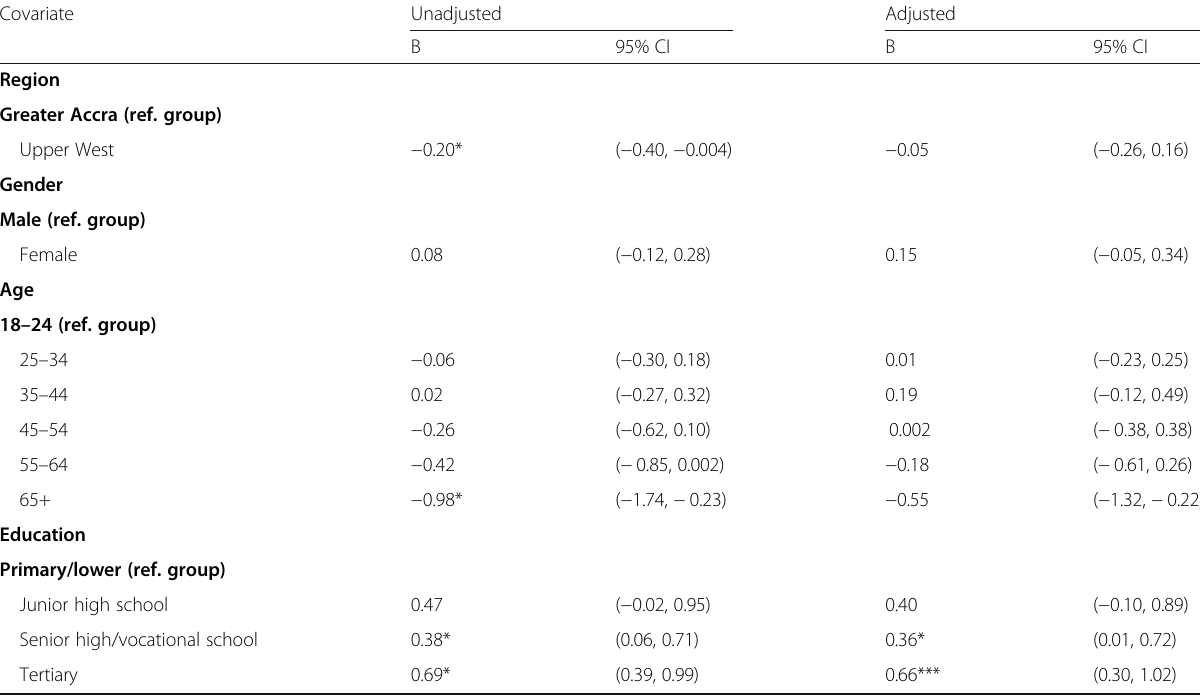
Table 4 OLS results for Attitudes towards actions to reduce antibiotic resistance ( n = 400) Covariate Unadjusted Adjusted B 95% CI 95% CI Region Greater Accra (ref.